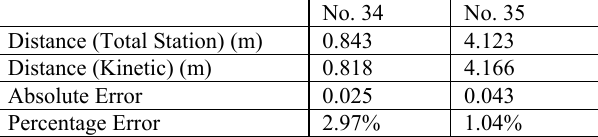
Table 2. Experimental Results of Sensing Data (Zhu and Donia, 2013a)